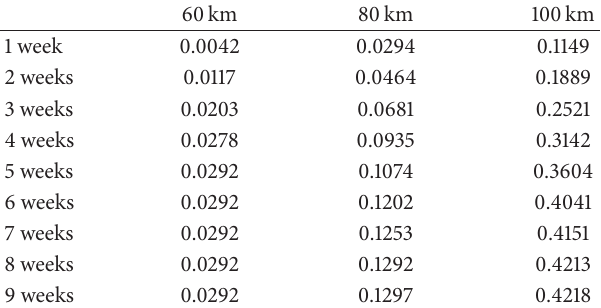
Table 6: Filtered AE as aftershocks from July 5, 2011 to September 5, 2011. Cumulative probability 𝐶 − ( r, 𝜏 ) for radius r ranging between 60 and 100 km, and time 𝜏 varying from 1 week to 9